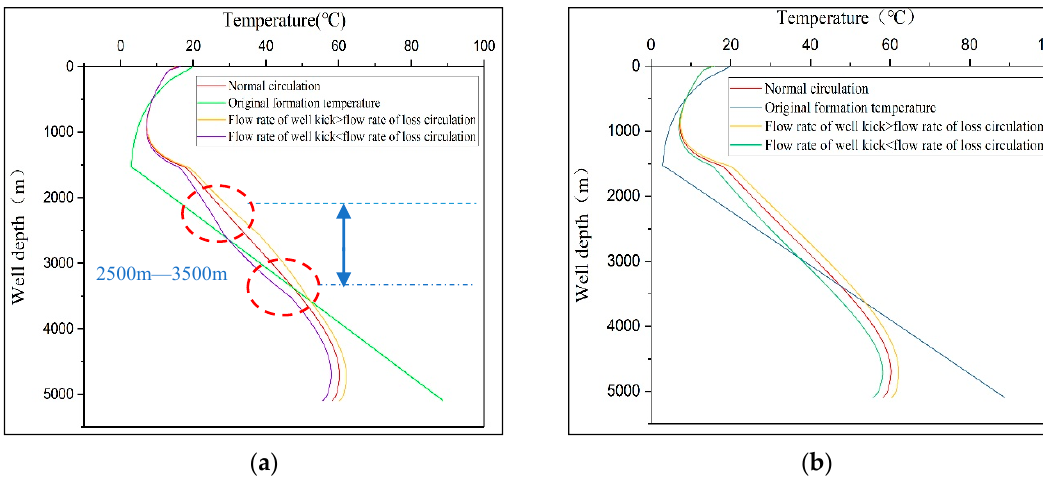
Figure 6. Annulus temperature distribution when overflow and leakage rates are different under the multi-pressure system; ( a ), ( b ) show conditions when the multi-pressure system is located in middle formation and at bottom hole, respectively.